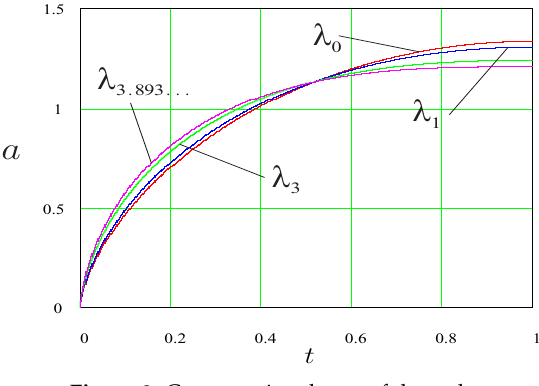
Figure 2. Cross-sectional area of the rod.